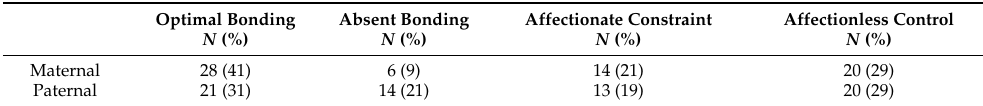
Table 3. Parental Bonding Instrument score distribution as percentage for the four types of parental bonding in the First Experimental Study of Transference Interference-In Teenagers (FEST-IT).